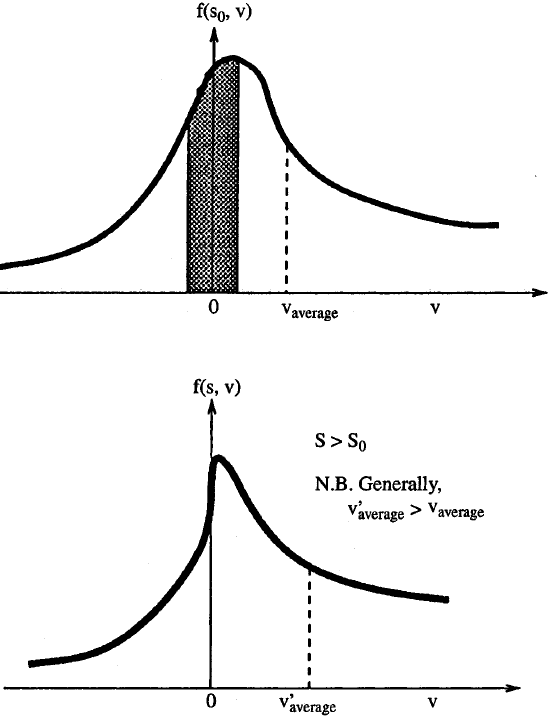
Fig. 18. Illustration of particle distribution evolution under an upward potential energy gradient. The shaded region corresponds to those particles that do not have su(cid:129)cient kinetic energy to reach s . These particles will be reflected between s 0 and s by the potential barrier, and thus make no contribution to the distribution at s . The kinetic e(cid:128)ect due to these reflected particles generally leads to a larger average velocity at s than at s